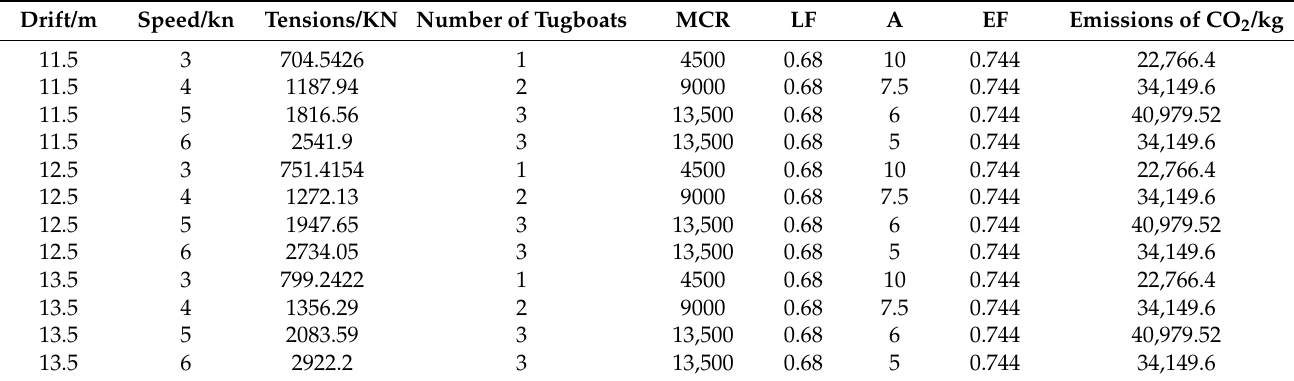
Table 6. Calculation of CO 2 emissions.